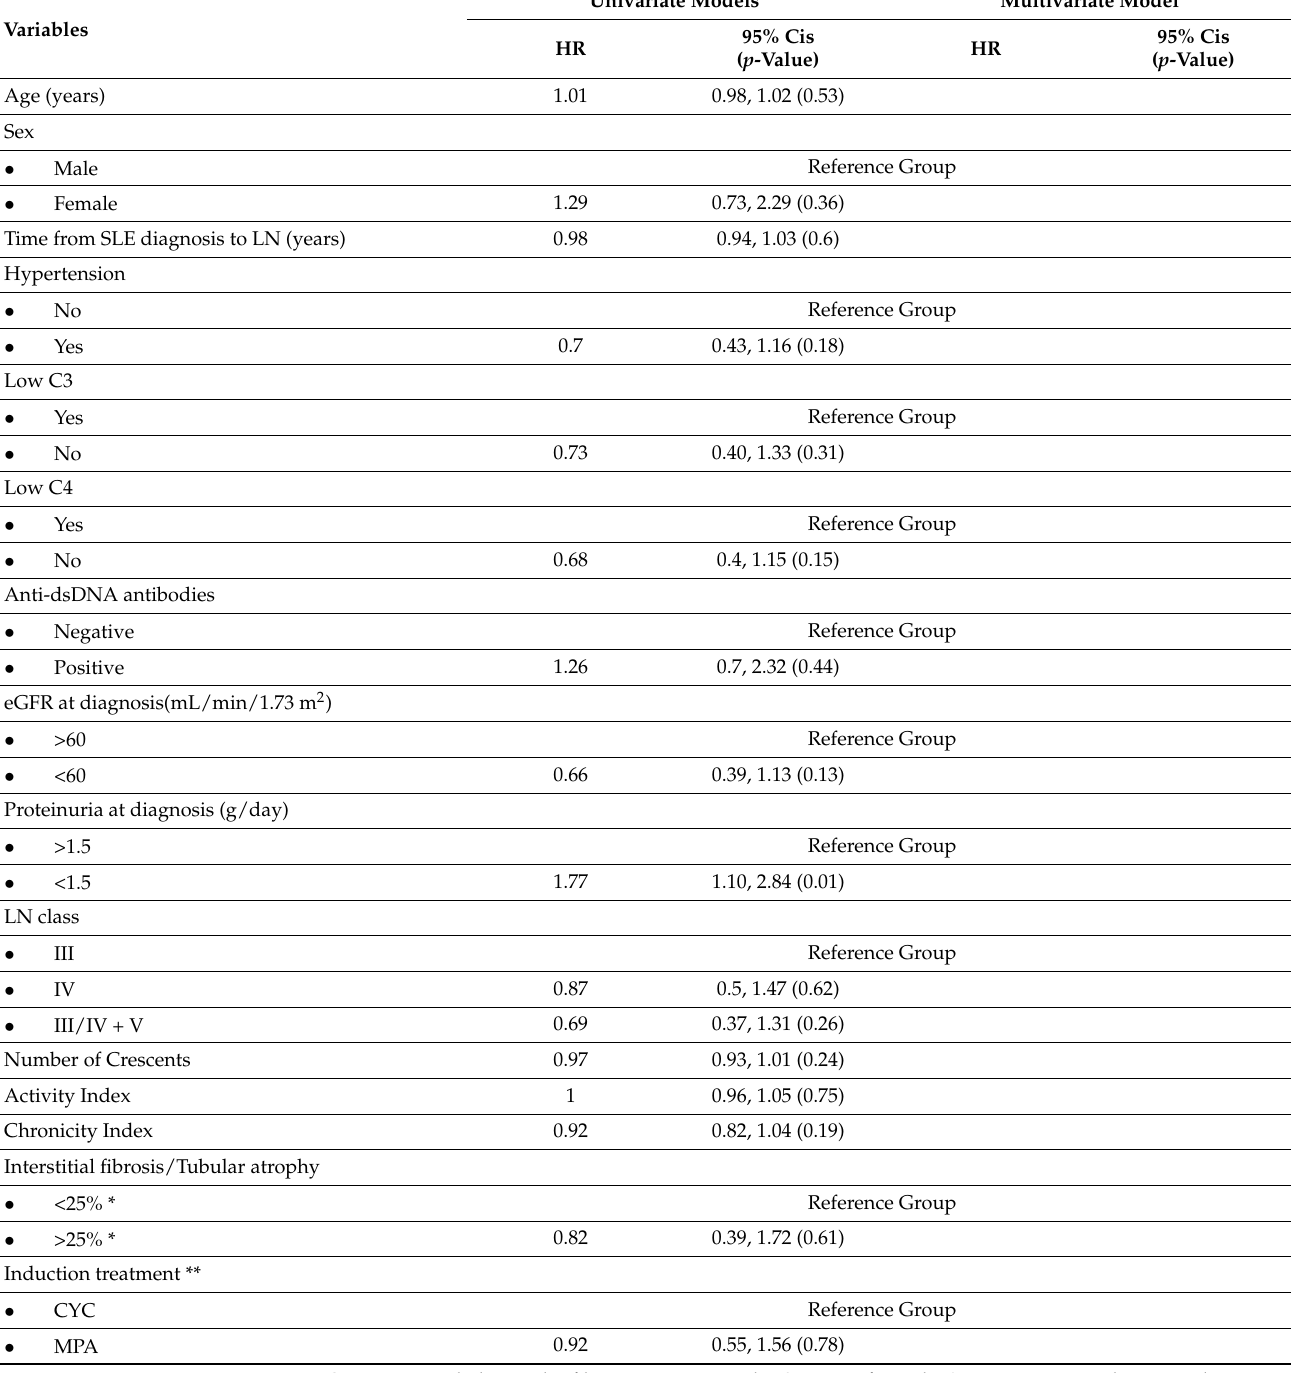
eGFR: estimated glomerular filtration rate using the CKD-EPI formula, SLEDAI: systemic lupus erythematosus disease activity index, anti-ds DNA: antibodies against double-stranded DNA, CYC: cyclophosphamide, MPA: mycophenolic acid. * refers to the percentage of the renal cortex involved by interstitial fibrosis and tubular atrophy, ** the two treatment groups were compared with and without the concomitant use of